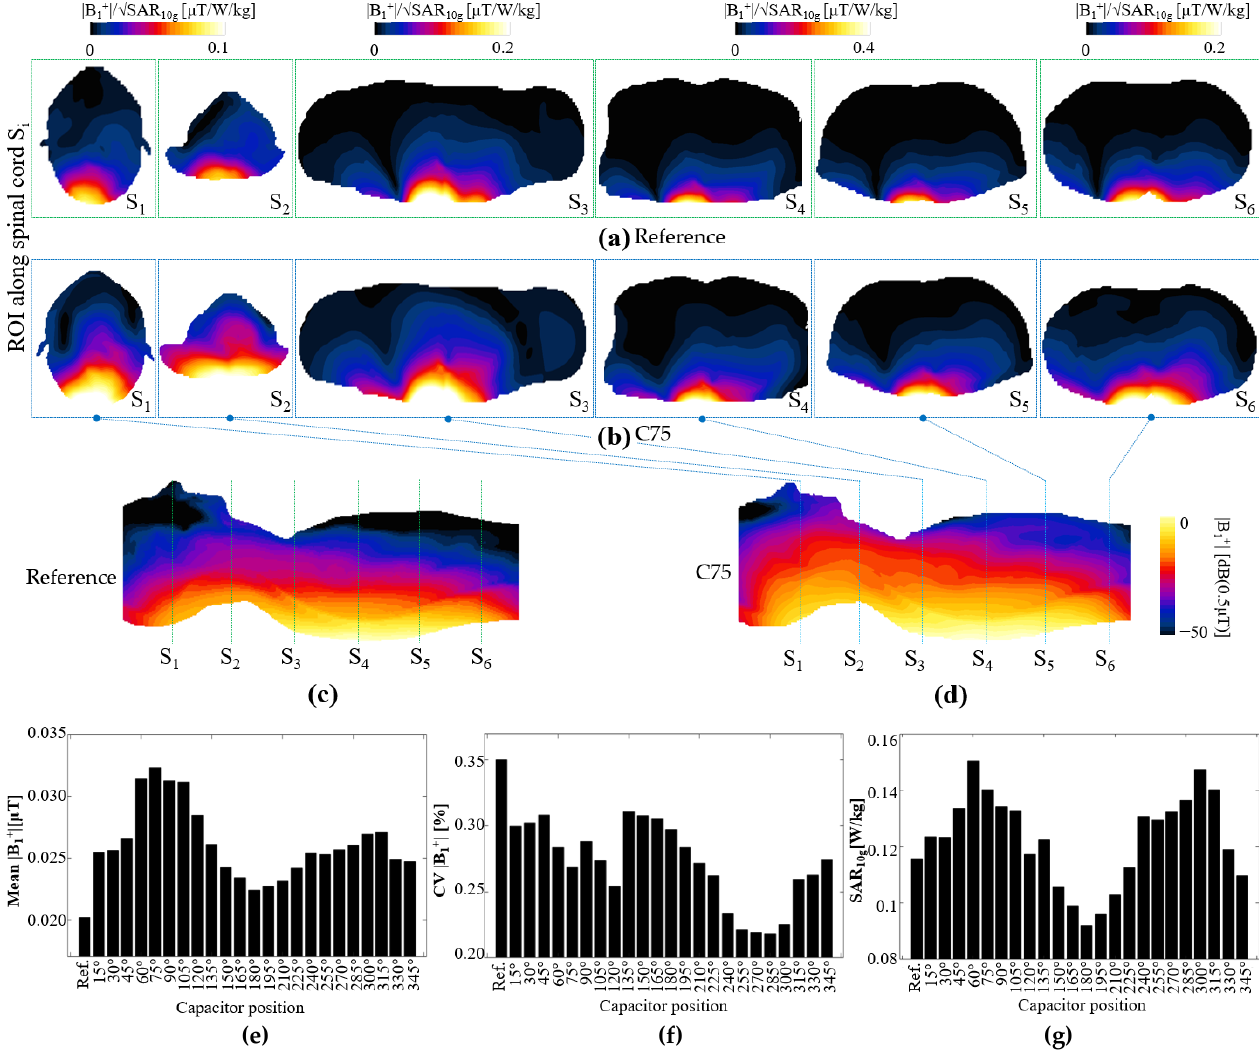
Figure 10. Computed |B 1+ | field in XY plane for arrays of ( a ) reference coils, with details shown in top row, and ( b ) coil with capacitor at position 75 ◦ , with details shown in bottom row. Computed |B 1+ | field in the ZY plane for the ( c ) reference array, and ( d ) the array with capacitor at position 75 ◦ , the selected ROIs are labeled as S i . Statistics of computed |B 1 + | field: ( e ) mean, ( f ) CV, and ( g ) maximum SAR 10g values for all tested coil